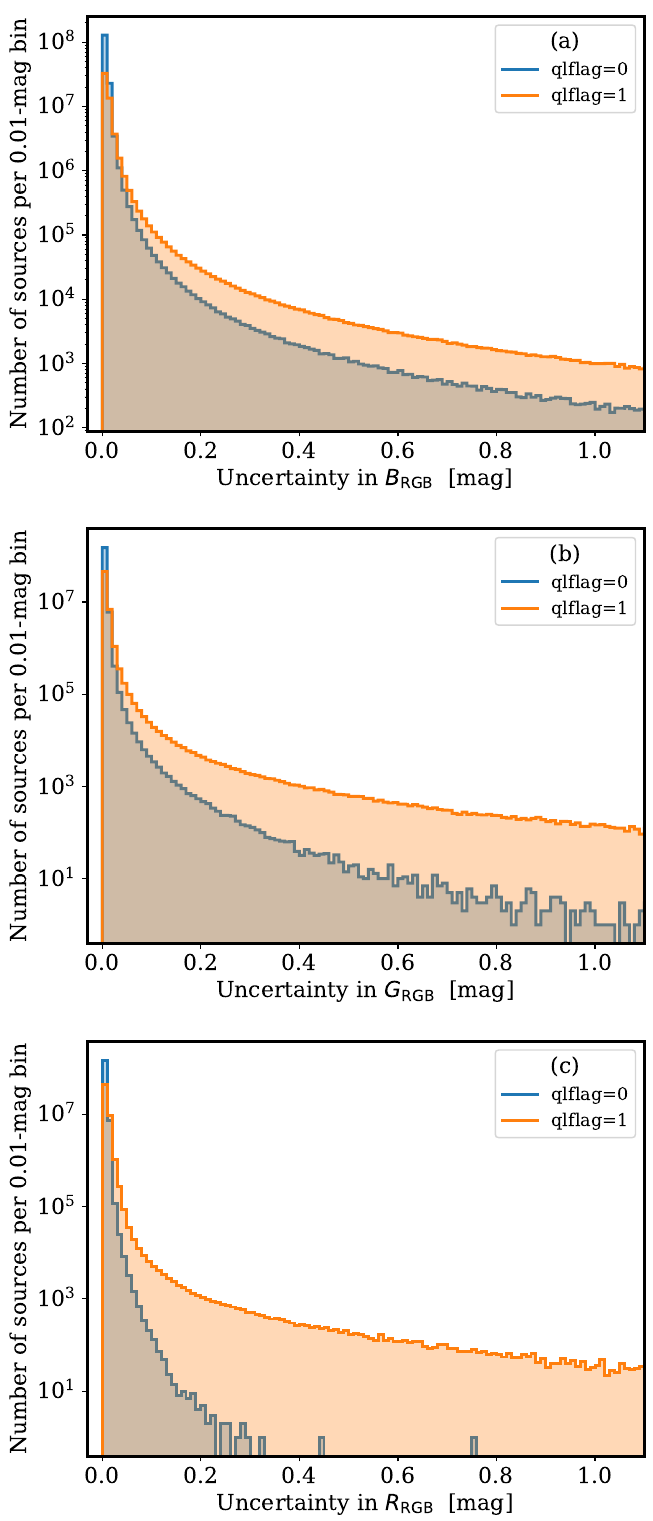
Figure 14. Histograms displaying the differences in the predicted uncertainties in the RGB synthetic magnitudes (panels ( a – c ) for B RGB , G RGB and R RGB , respectively) as a function of the global quality parameter qlflag (last column in Table 2). As expected, the objects with poorer quality (qlflag = 1) exhibit larger